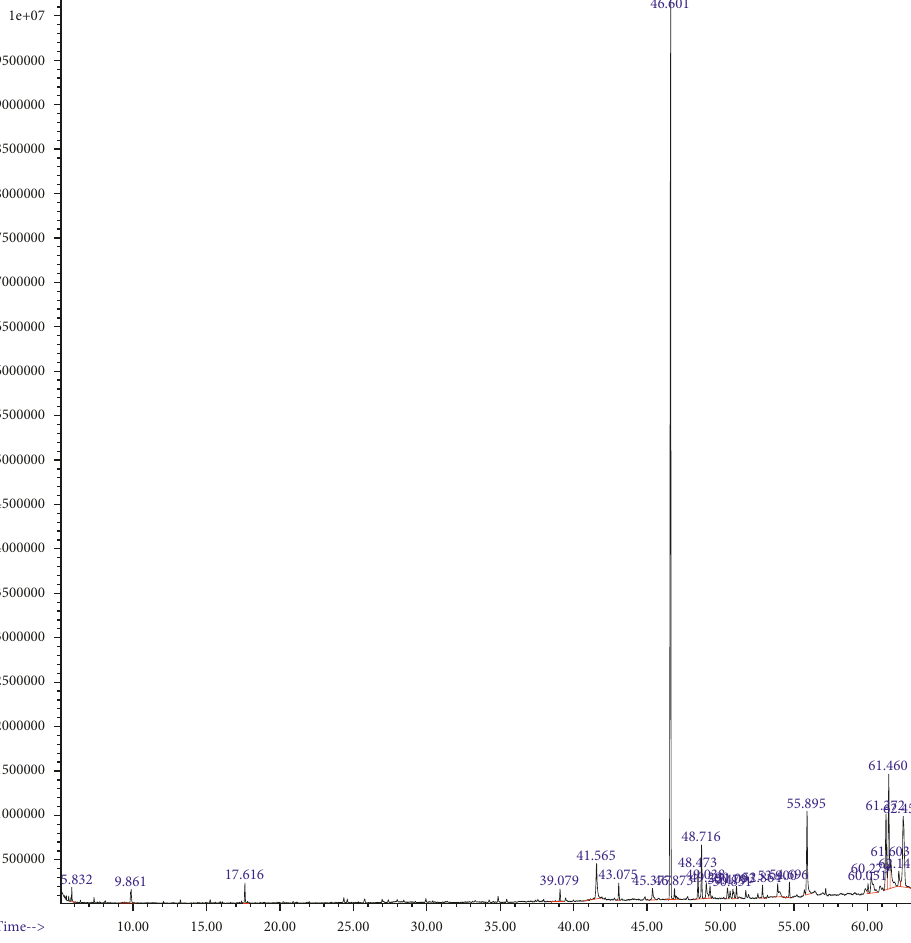
Figure 4: GC-MS chromatogram of methanol extract of N. pulmonarioides.